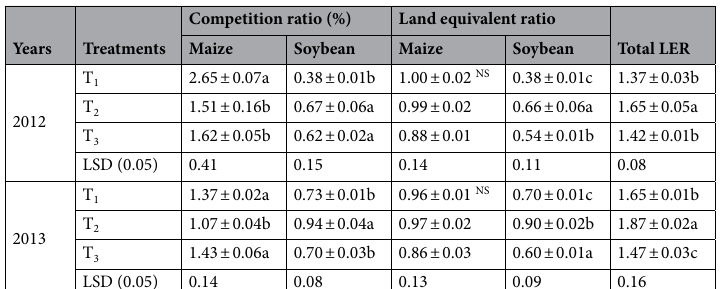
Table 6. Effect of different strip-width treatments on competition ratios and land equivalent ratios (LER) of maize and soybean in cropping seasons from 2012 to 2013. Treatment codes represent narrow-strips (T 1 , 180 cm); medium-strips (T 2 , 200 cm); and wide-strips (T 3 , 220 cm) in maize/soybean relay intercropping system. Means are averages over three replicates ± standard error of the mean. Means that do not share the same letters in a column differ significantly at p ≤ 0.05 using least significant differences, calculated separately for each year. NS